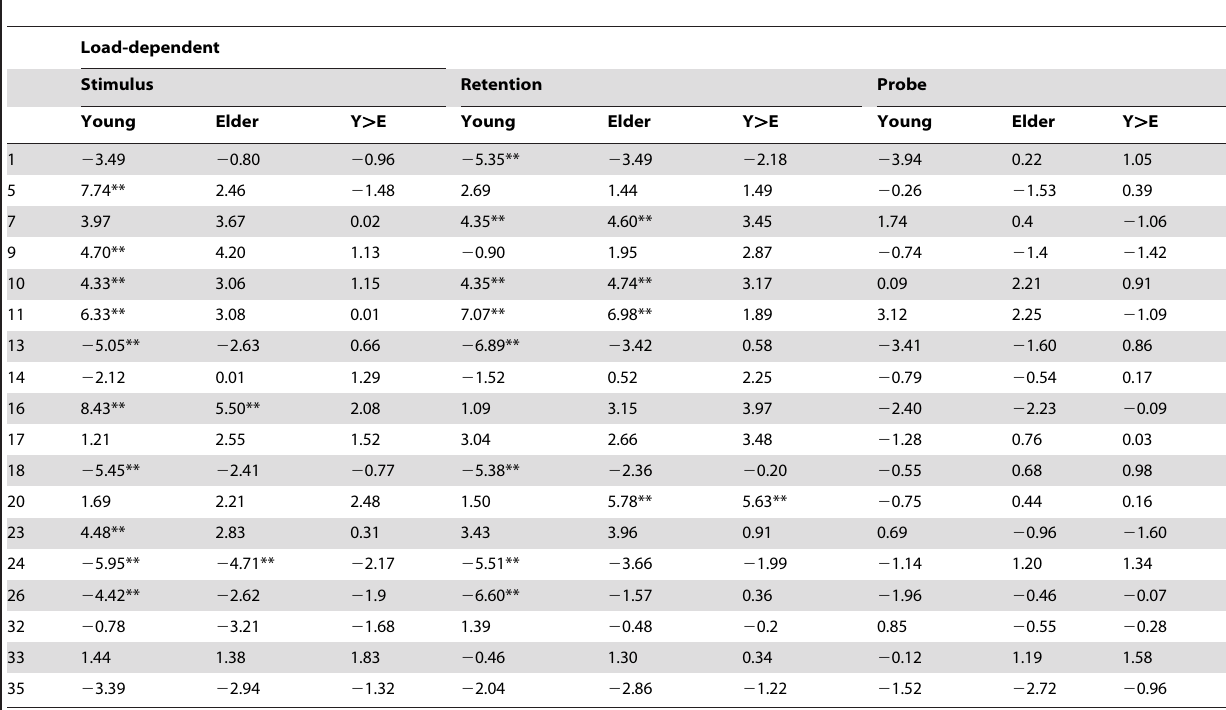
Table 2. Within and between age group comparisons of the individual time-course of each component and the load dependent contrasts for each task